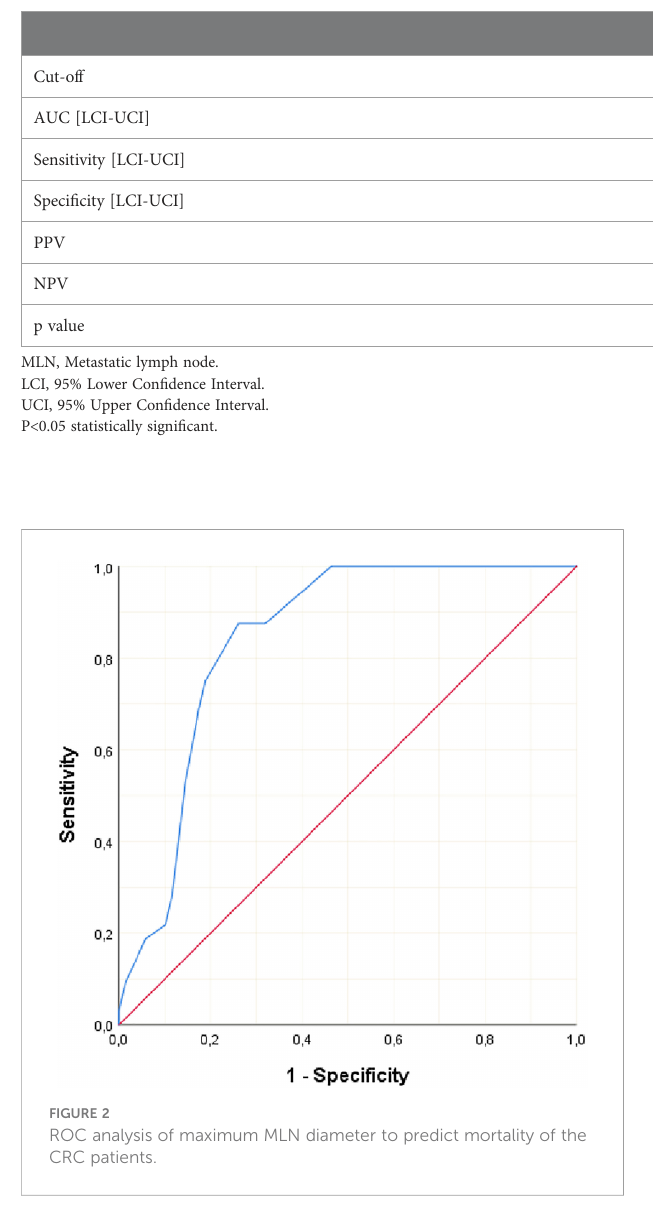
TABLE 3 ROC analysis of the maximum MLN diameter to predict mortality of the CRC